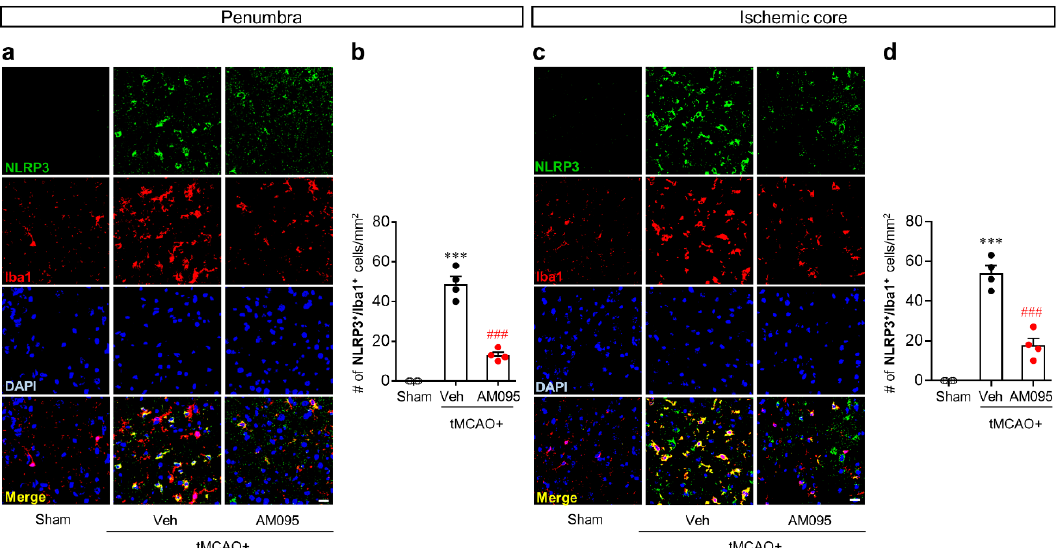
Figure 2. LPA 1 antagonist attenuates NLRP3 upregulation in ionized calcium-binding adapter molecule 1 (Iba1)-immunopostive cells of injured brains after tMCAO challenge. Mice were induced with tMCAO. AM095 (30 mg / kg) was administered immediately after reperfusion. NLRP3 expression in Iba1-immunopositive cells was determined in the penumbra and ischemic core regions at one day after tMCAO challenge by NLRP3 / Iba1 double immunofluorescence. Representative image of NLRP3 / Iba1-double immunopositive cells in the penumbra ( a ) and ischemic core regions ( c ) and quantification of their numbers ( b , d ) are shown. Scale bars, 20 µ m. n = 4 mice per group. *** p < 0.001 versus sham. ### p < 0.001 versus vehicle-administered tMCAO group.